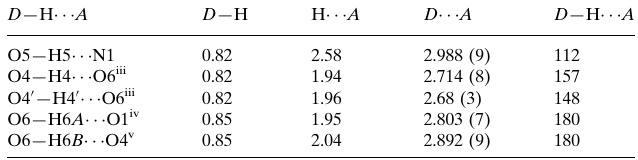
Hydrogen-bond geometry (A˚ , (cid:4)